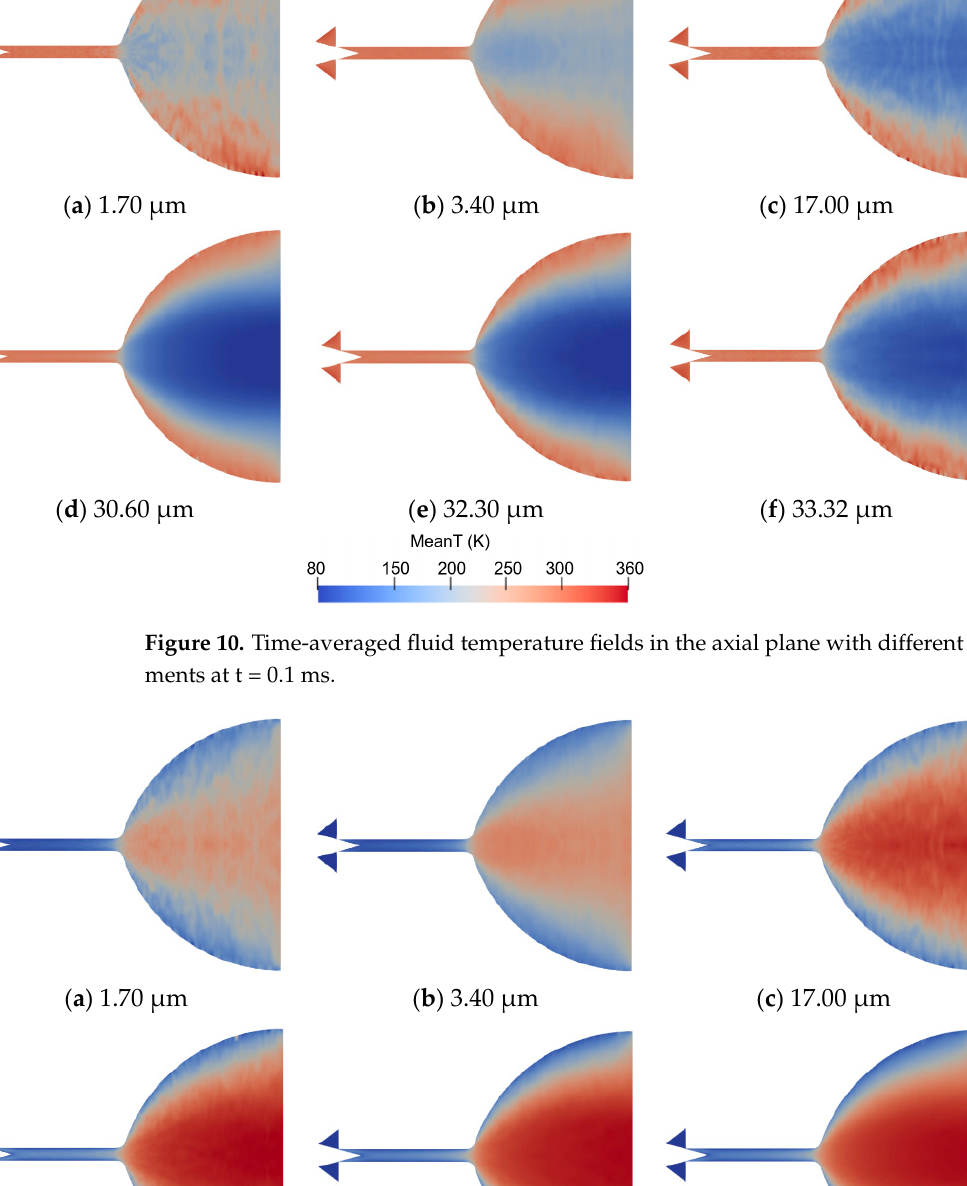
Figure 11. Time-averaged fluid velocity fields in the axial plane with different needle displacements at t = 0.1 ms .